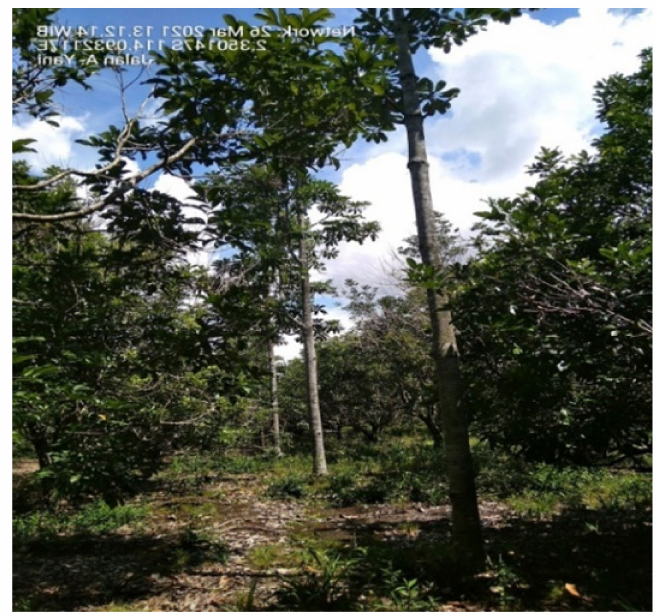
Figure 4. Balangeran and rambutan